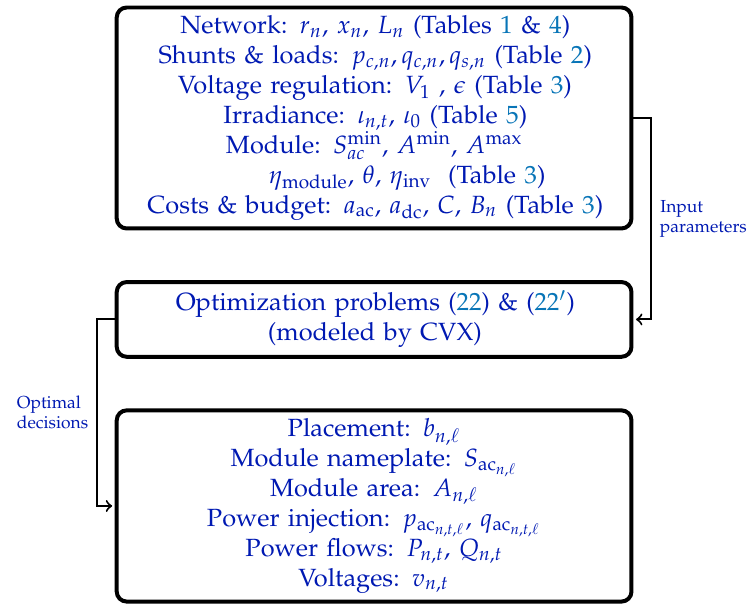
Figure 4. A diagram of the approach. The first block collects and organizes the input parameters required for the optimization problem. Refer to the tables in parenthesis for specific values of these paremeters. The second block portrays the optimization problem that are carried out by CVX. Upon solving the optimization problems, optimal placement and sizing decisions as well as estimates of nodal voltages and branch power flows are output to the third